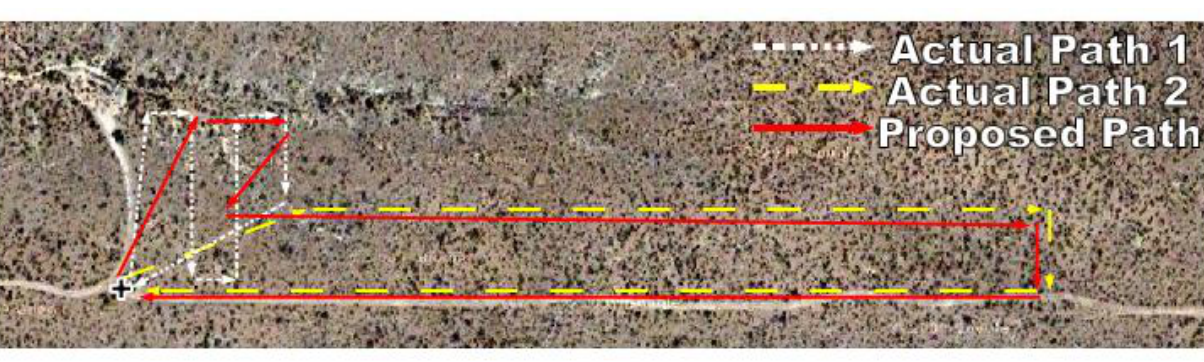
Figure 10: Actual (white and yellow) and proposed (red) flight paths of imaging area in Las Cruces, New Mexico (400 x 100 m)